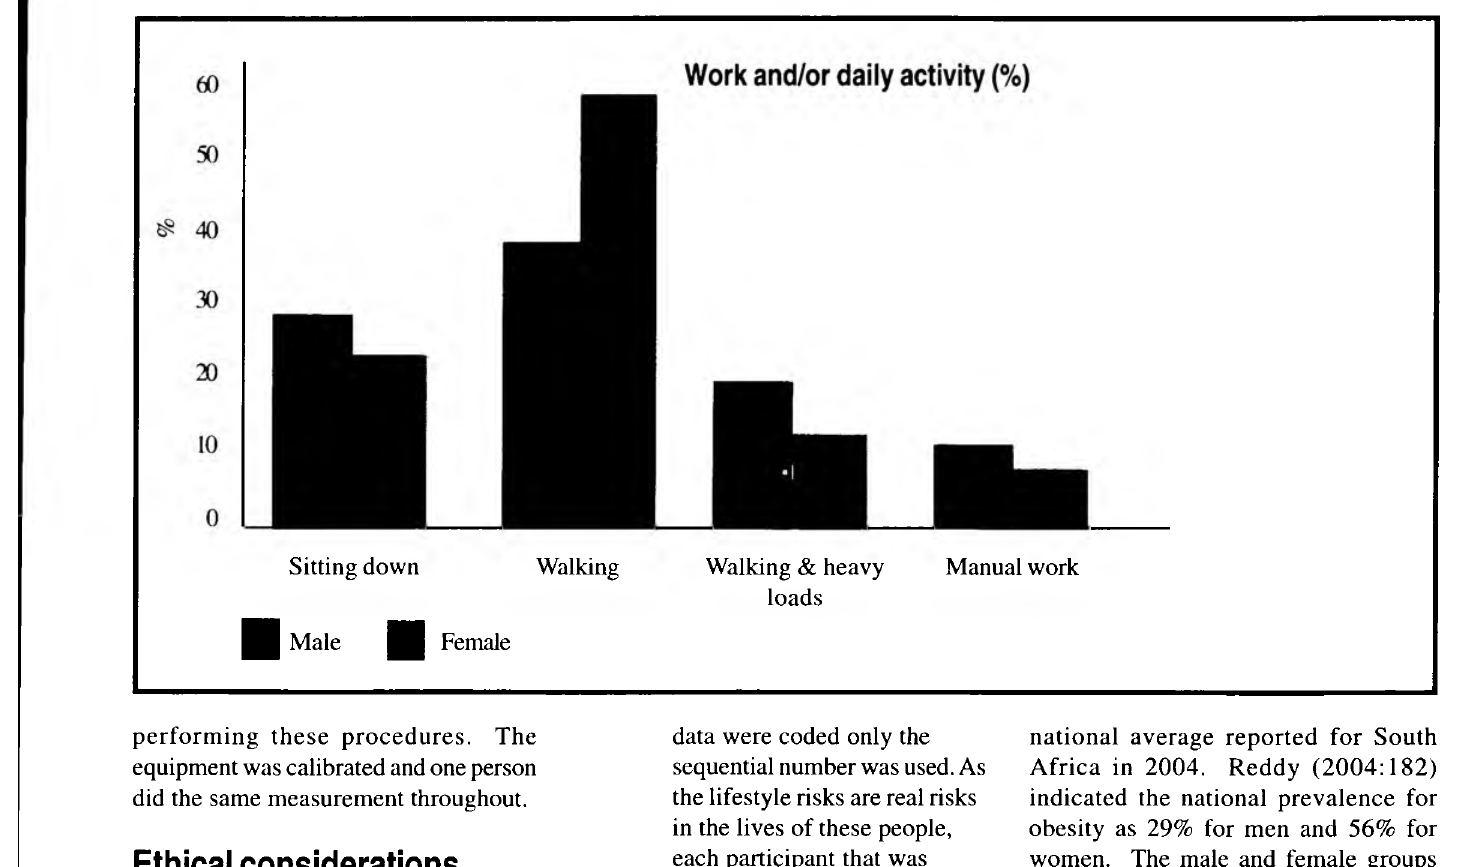
Sitting down Walking Walking & heavy Manual work